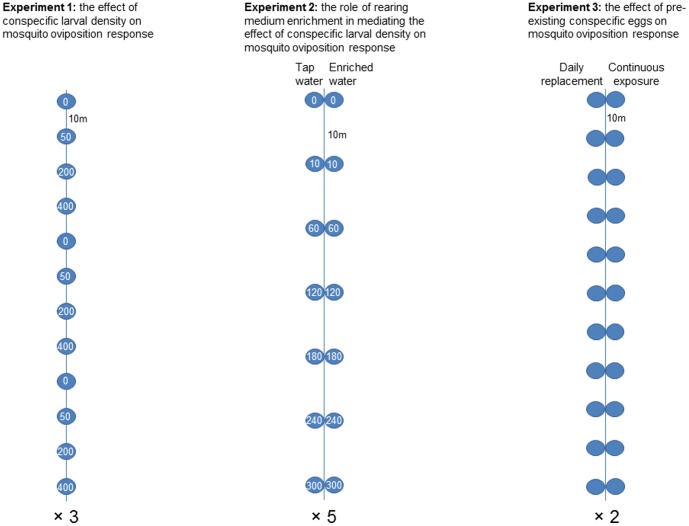
Experimental design.Transect are represented by lines and blue circles represent the oviposition cups. Numbers inside the circles represent the initial number of larvae introduced (experiments 1 and 2). Numbers underneath transects represent the number of spatial replicates.